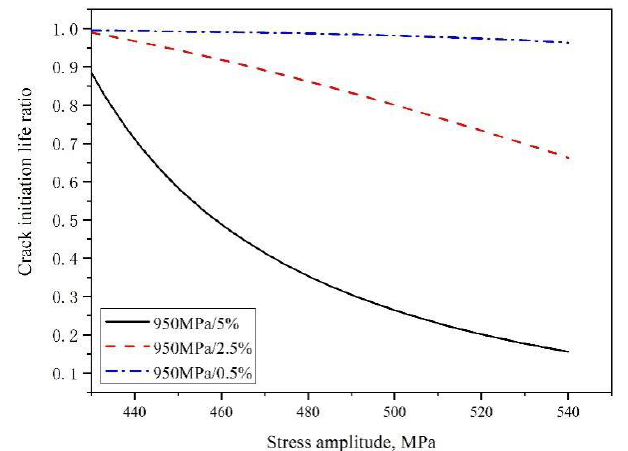
Figure 11. Prediction of fatigue crack initiation life ratio of TC21 titanium alloy after LCF predamage.